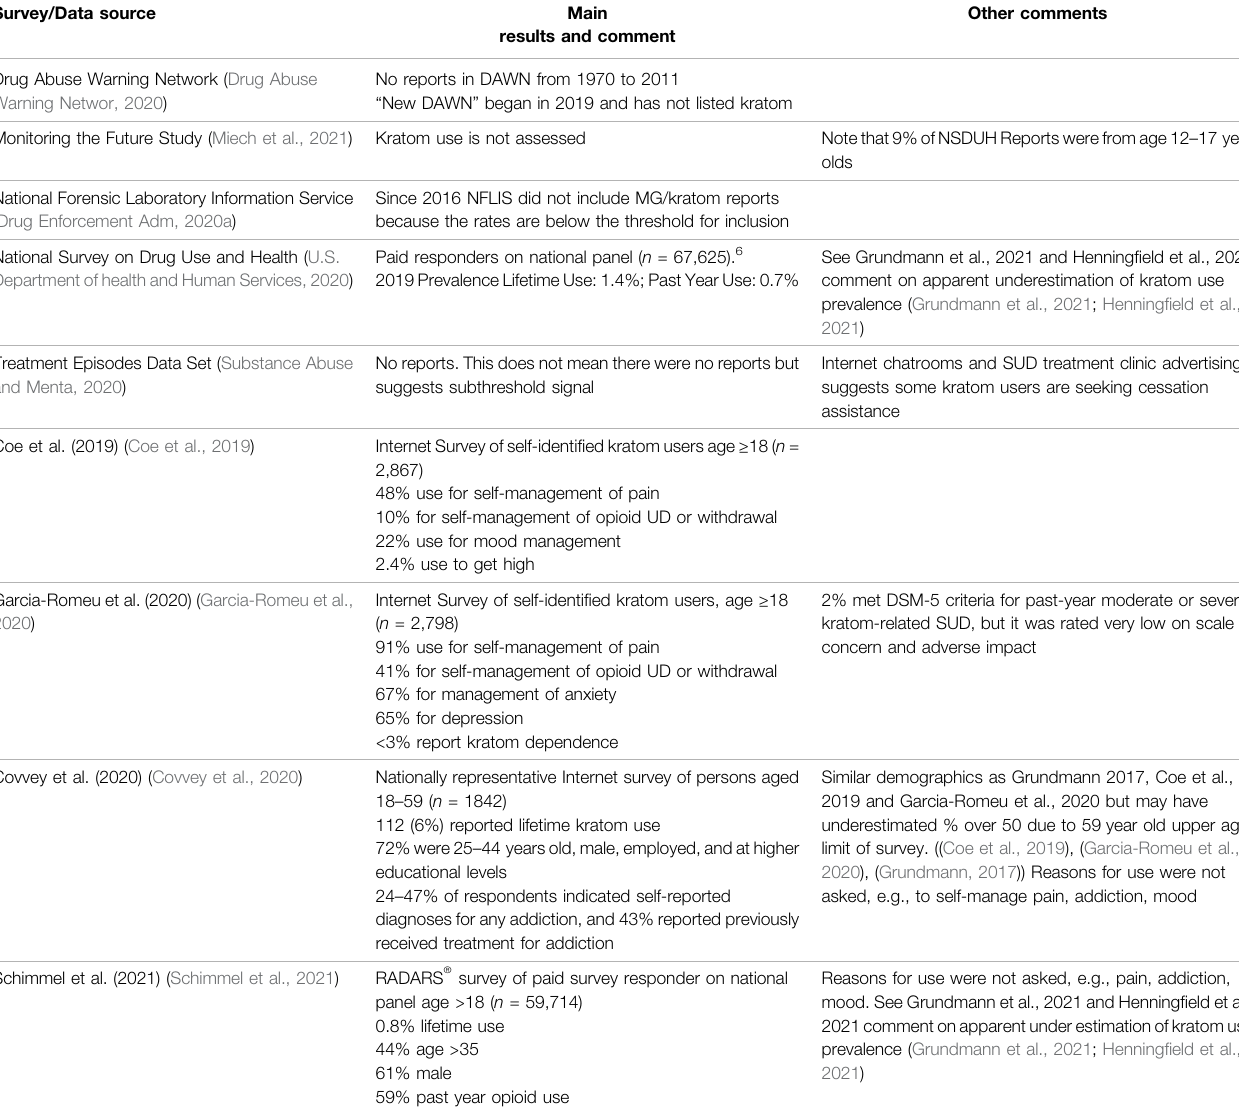
TABLE 2 | Summary of data